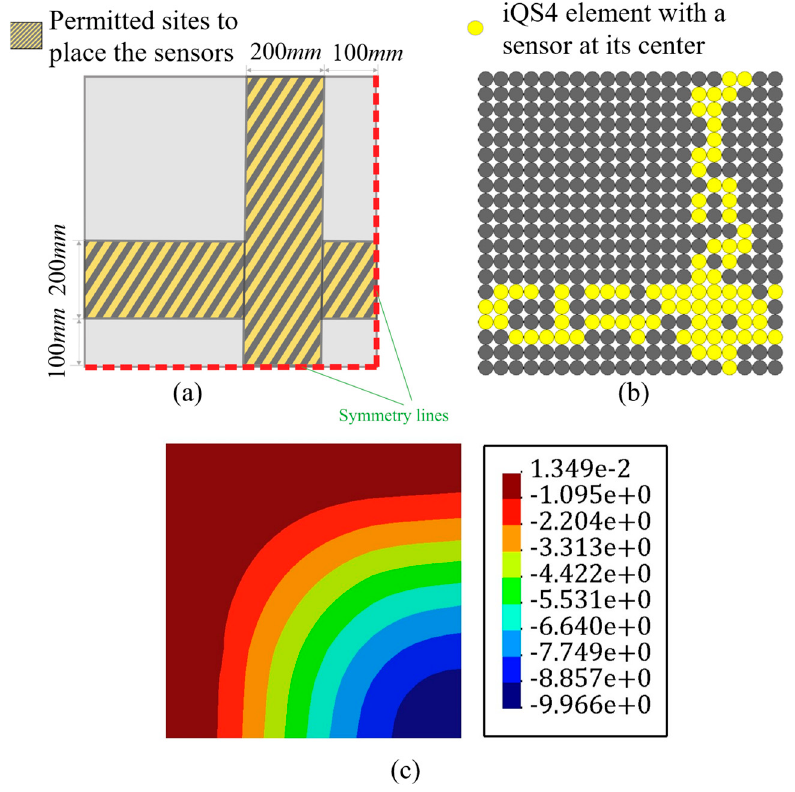
Figure 22. The iFEM-GA results of the plate depicted in Figure 19 with limited search space. ( a ) The permitted sites to place sensors, ( b ) optimum sensor placement, and ( c ) displacement contours.